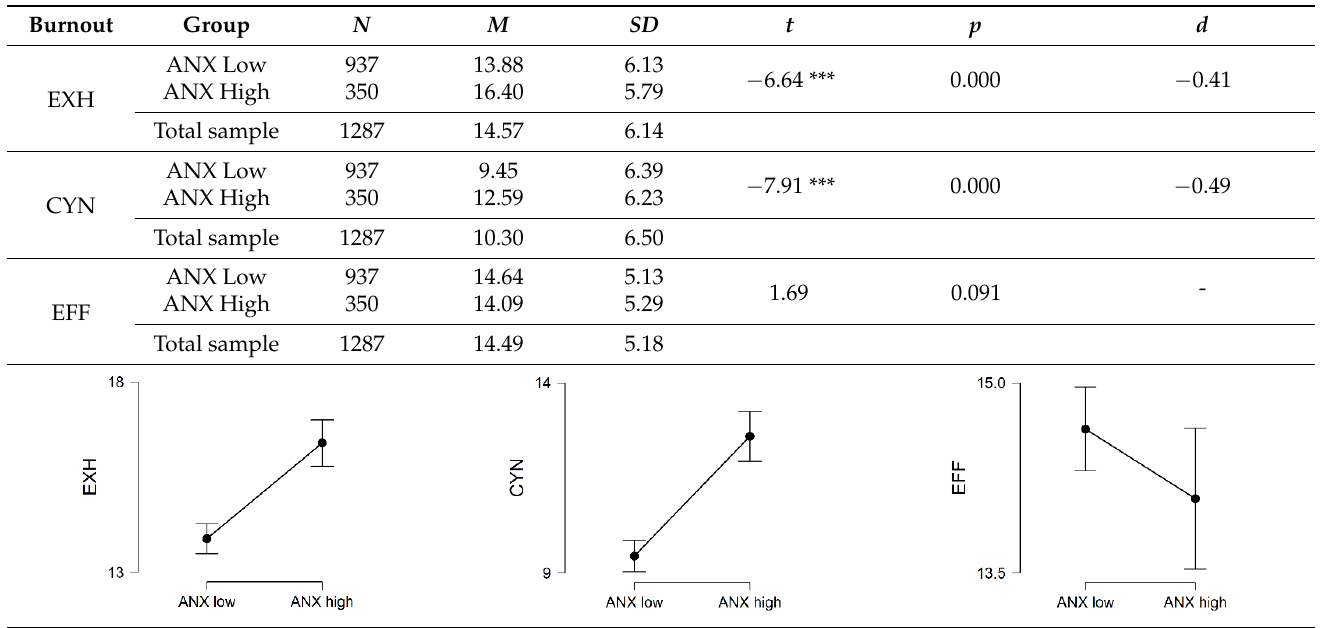
Table 2. Differences in burnout by level of anxiety sensitivity.